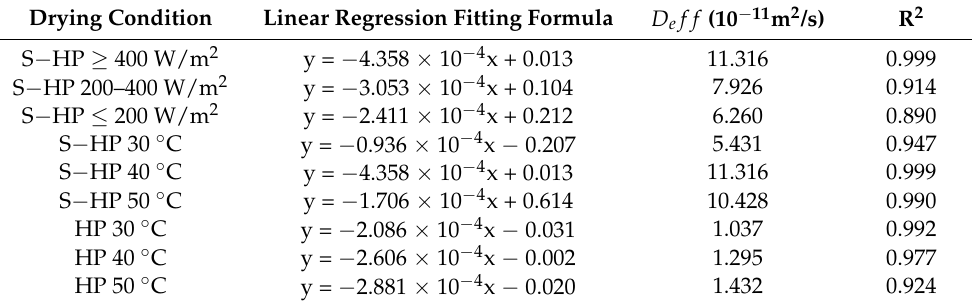
Table 6. Effective moisture diffusivity under different drying